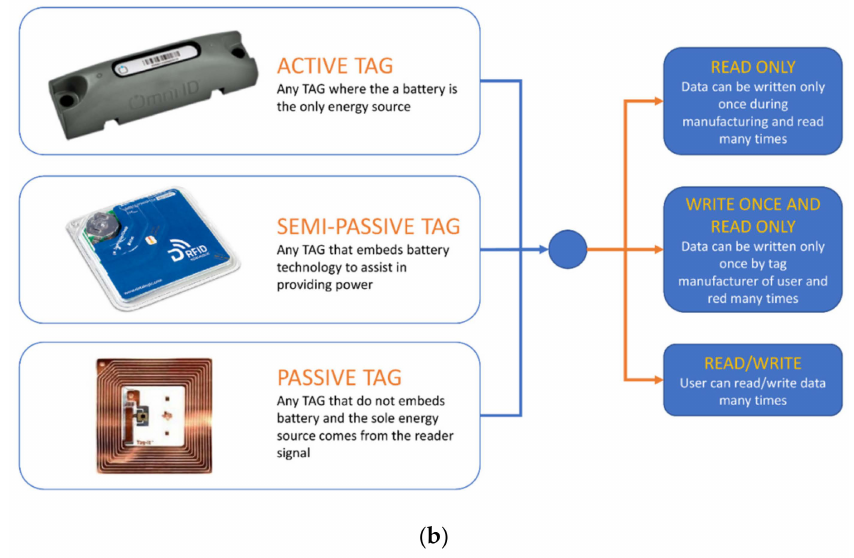
Figure 4. RFID technology classification based on ( a ) the frequency of operation; ( b ) active, semi-passive, or passive circuitry.